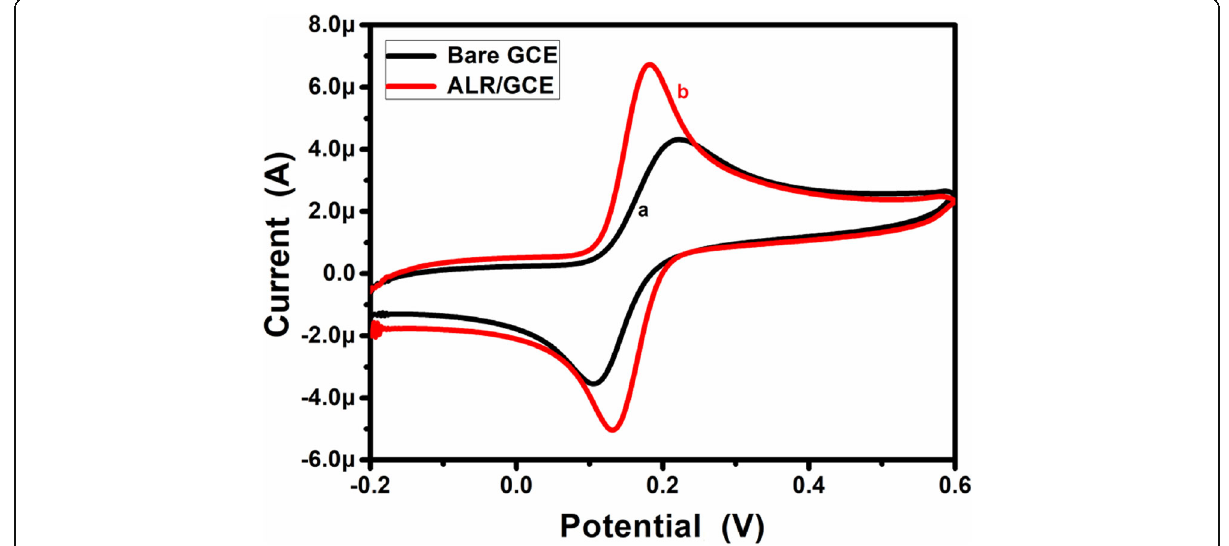
Fig. 1 CVs of 40.0 μ M CC at bare GCE (curve a) and ALR/GCE (curve b) in 0.2 M buffer of pH 7.4 with 0.05 Vs − 1 scan